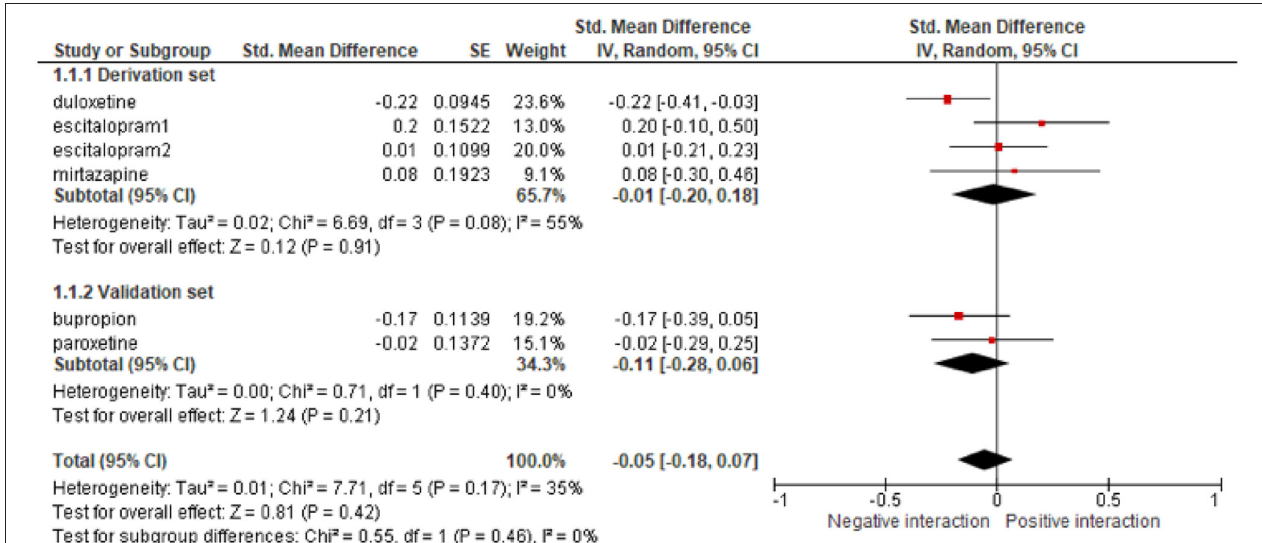
FIGURE 2 | Example of the analysis of the efficacy of anti-depressants at the trial level in subgroups of trials defined by the baseline severity of major depression, reproduced from Furukawa et al. ( 26). SE, standard